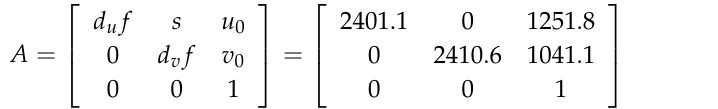
twelve columns. On the chessboard, 30 images were captured with different positions and orientations.